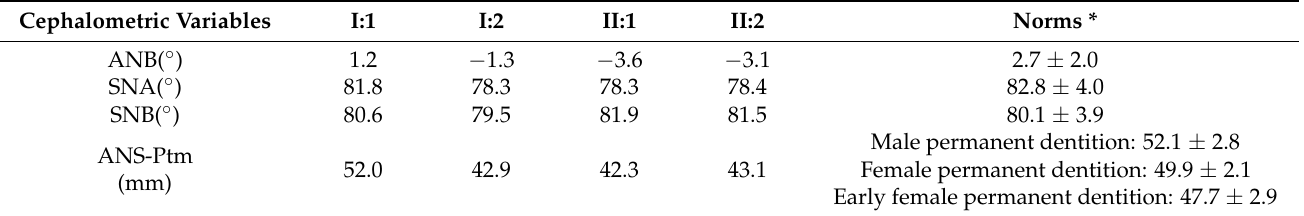
Table 1. Summary of measurements in all